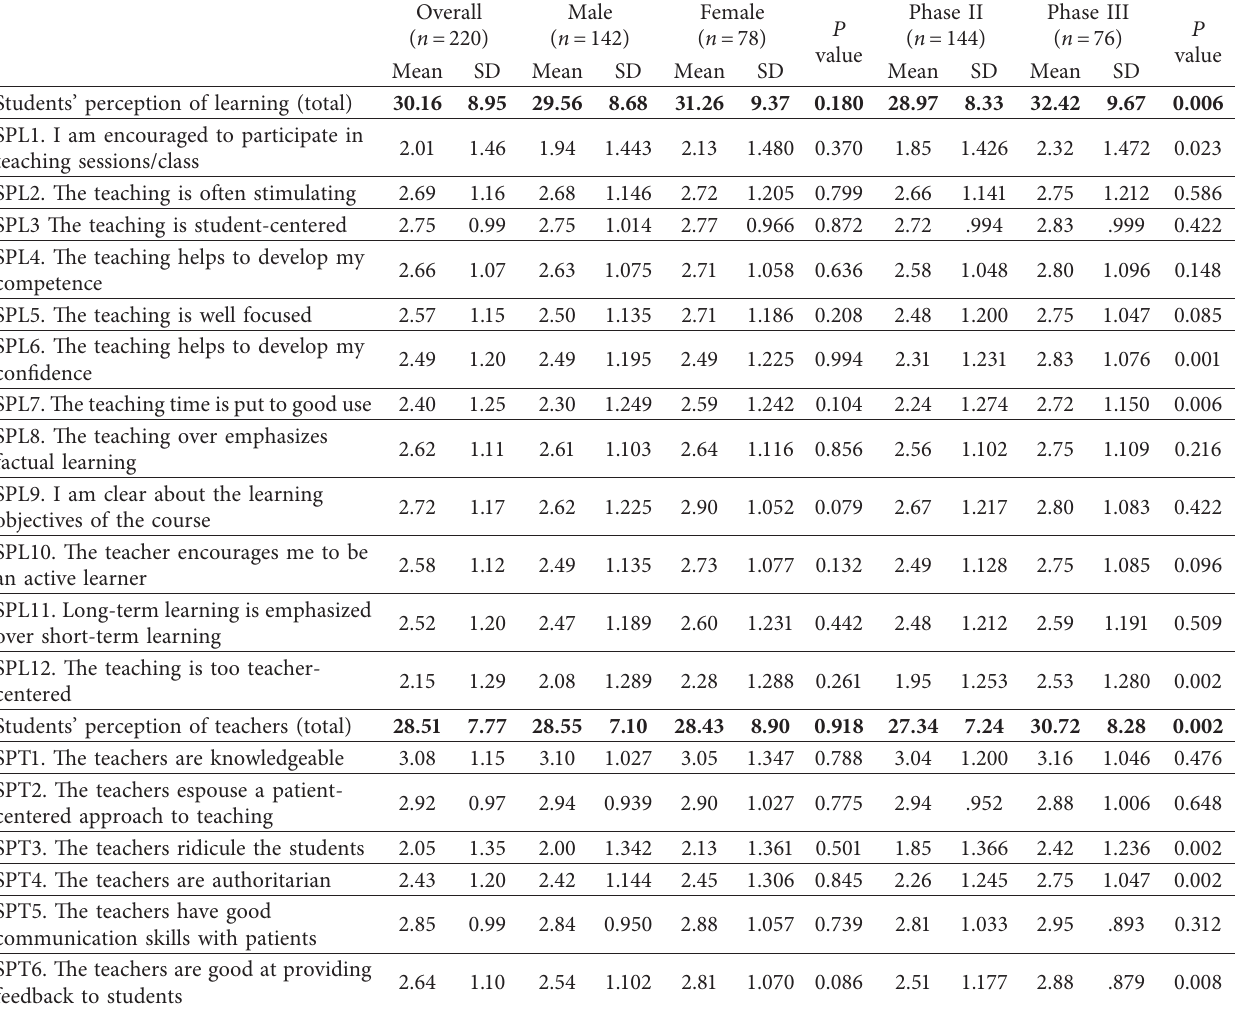
Table 5: Mean (SD) DREEM scores of the domains differentiated as per gender and phase of